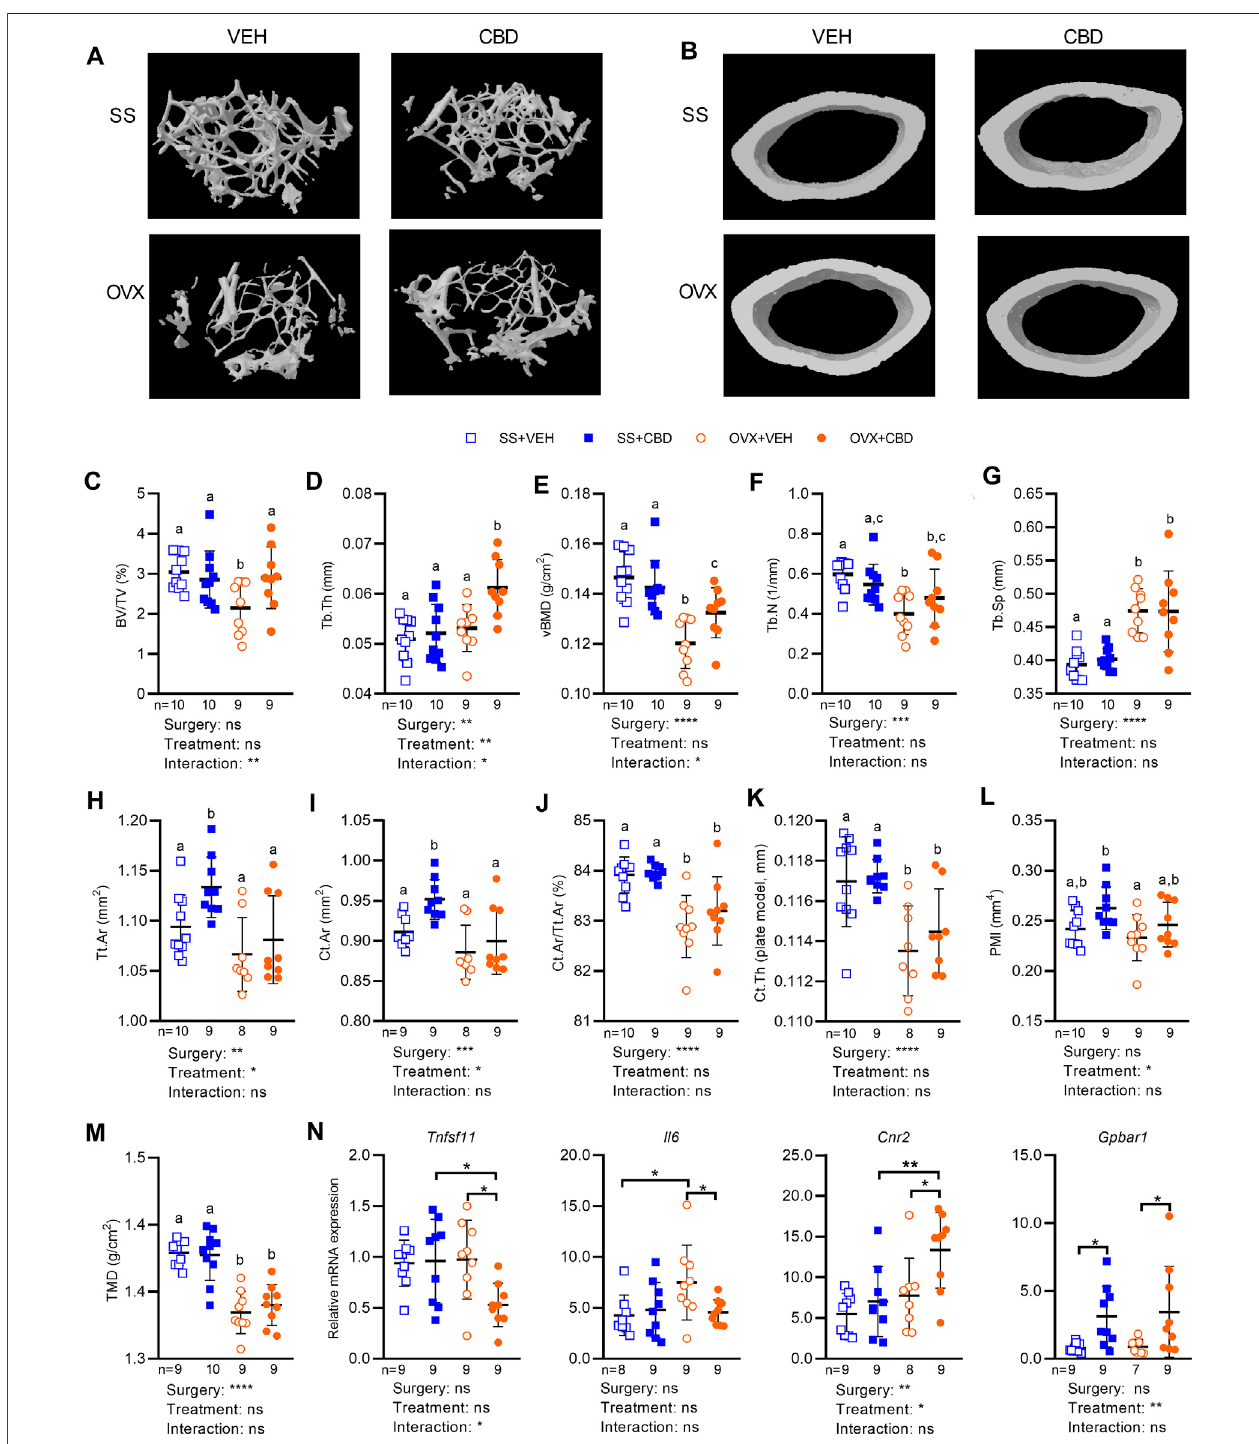
FIGURE4| CBDimprovedfemoralmicrostructureconsistentwithgeneexpressionmarkersofreducedin fl ammationandlessboneresorption.MicroCTimagesof femoral bone microstructure showing (A) trabecular bone and (B) cortical bone from SS and OVX groups after 18 weeks of VEH or CBD treatment. Femoral microstructure of trabecular bone showing (C) bone volume/tissue volume, BV/TV (%) (D) trabecular thickness, Tb.Th (mm) (E) volumetric bone mineral density, vBMD (g/cm 2 ) (F) trabecular number, Tb.N (1/mm) (G) trabecular separation, Tb. Sp (mm) and cortical bone showing (H) mean total cross-sectional tissue area, Tt. Ar (mm 2 ) (I) meantotalcross-sectionalbonearea,Ct.Ar(mm 2 ) (J) corticalbonefraction,Ct.Ar/Tt.Ar(%) (K) corticalthickness,Ct.Th(platemodel,mm) (L) polarmomentof inertia, PMI (mm 4 ) (M) tissue mineral density, TMD (g/cm 2 ). Data are presented as mean ± SD from 9 mice per OVX group and 10 mice per SS group. ROUT test